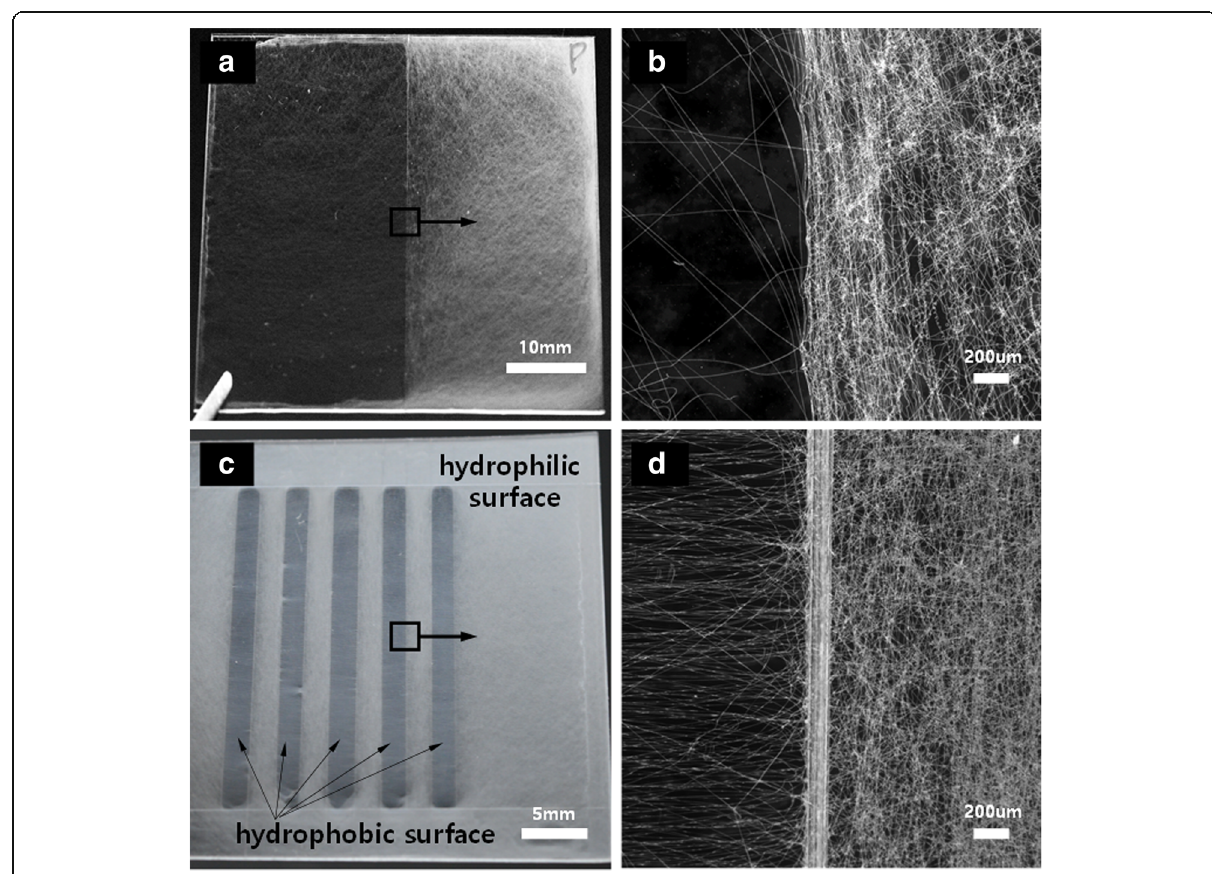
Fig. 2 Images of far-field electrospun films on surfaces with different wettabilities. a , c Digital camera photographs. b , d Digital micrographs of the boundary region of a and c ,